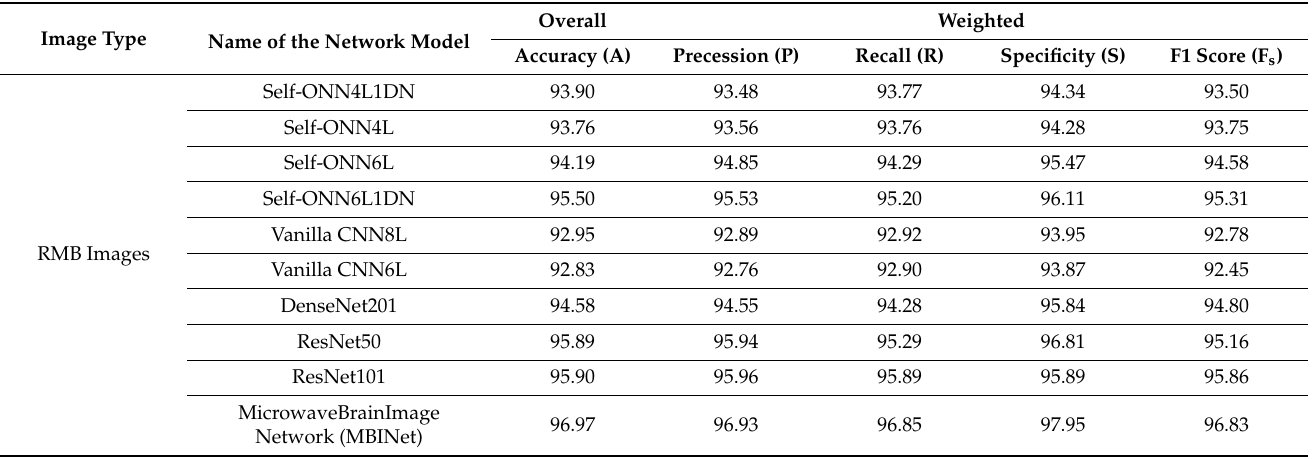
Table 4. Classification results of all models for the RMB brain images. Bold represents the best- performing